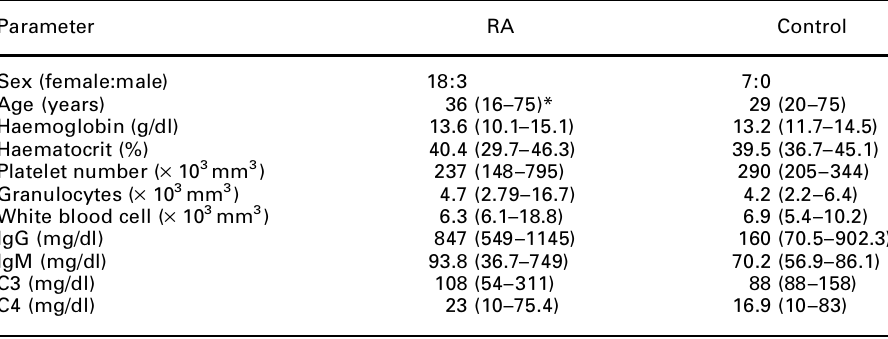
Table 1. Clinical and laboratorial features of the studied groups Parameter RA